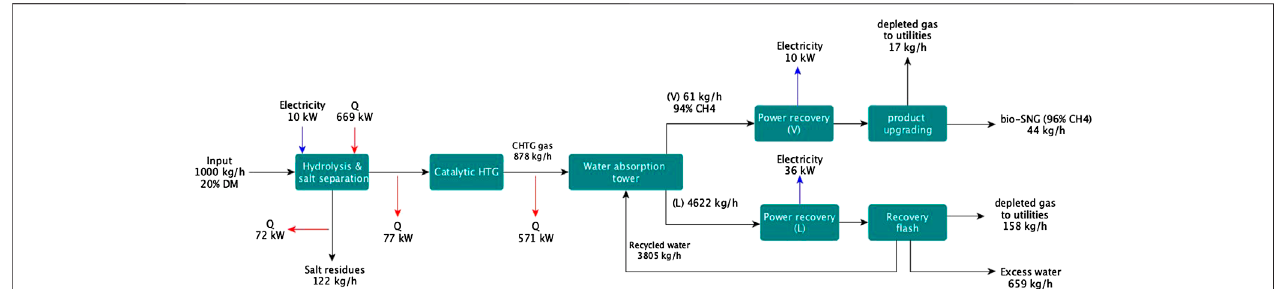
FIGURE 3 | Catalytic hydrothermal gasi fi cation schematic